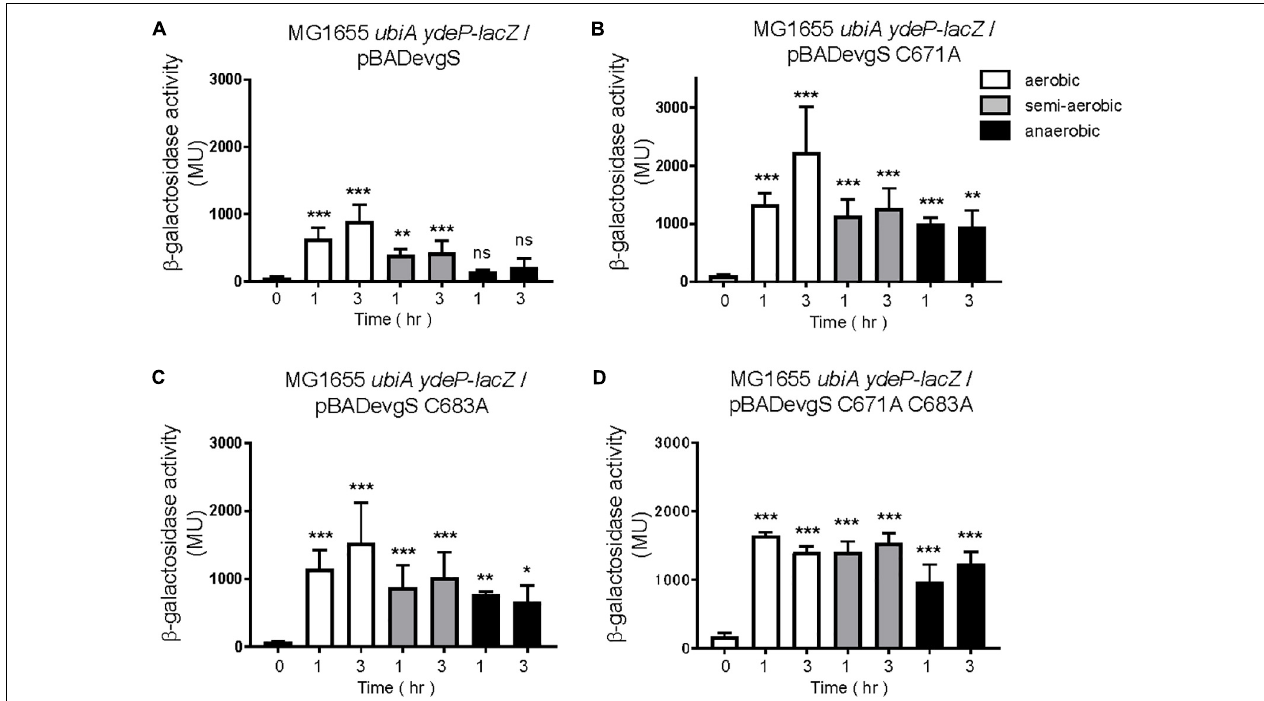
FIGURE 9 | Ubiquinone is not essential for EvgS/EvgA activation in strains overexpressing EvgS and EvgS-PAS mutants. (A–D) Activity of the ydeP-lacZ reporter in different culturing conditions (upper panel). Cells were grown in EvgS activation-medium with 0.02% arabinose and 1 mM uracil under aerobic (white bars), semi-aerobic (gray bars), or anaerobic condition (black bars) at 37 ◦ C. Optical density at 600 nm of the cell cultures subjected to reporter assays is shown in Supplementary Figure 14 . Data represent the average of three biologically independent replicates. Error bars indicate the standard deviation, and statistical analyses of each redox condition group were performed as described in Figure 1 . ns, not significant; *0.01 ≤ p < 0.05; **0.001 ≤ p < 0.01; *** p < 0.001. (A) MG1655 ubiA ydeP-lacZ/ pBADevgS, (B) MG1655 ubiA ydeP-lacZ/ pBADevgS C671A, (C) MG1655 ubiA ydeP-lacZ/ pBADevgS C683A, (D) MG1655 ubiA ydeP-lacZ/ pBADevgS C671A